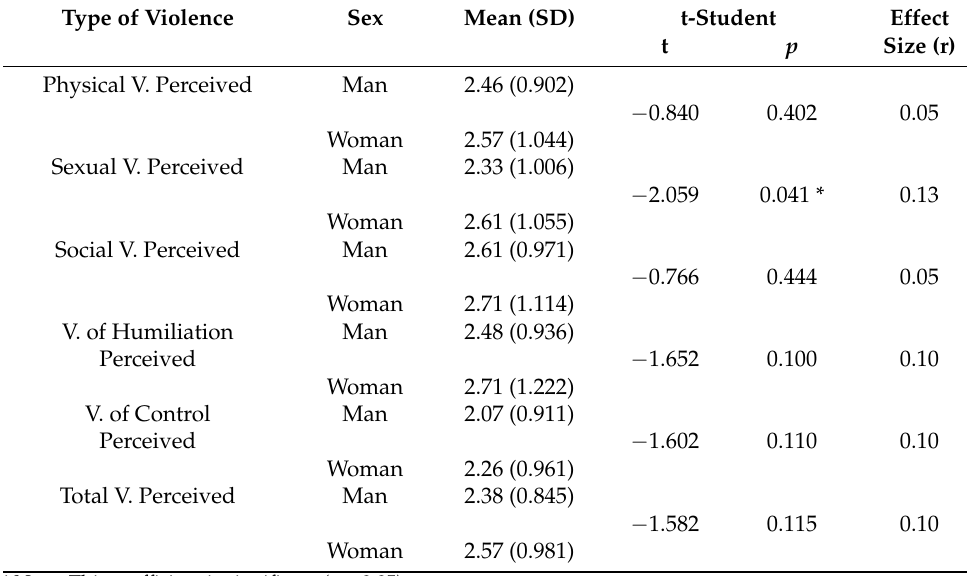
Table 5. Differences in Violence Perceived according to sex.